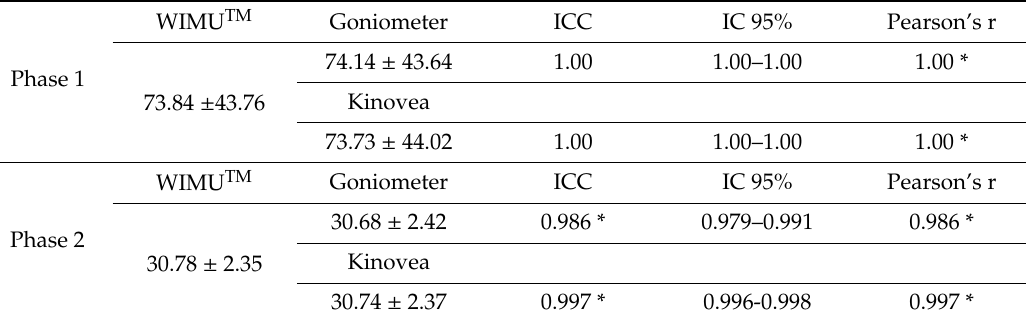
Table 2. Test-retest reliability .